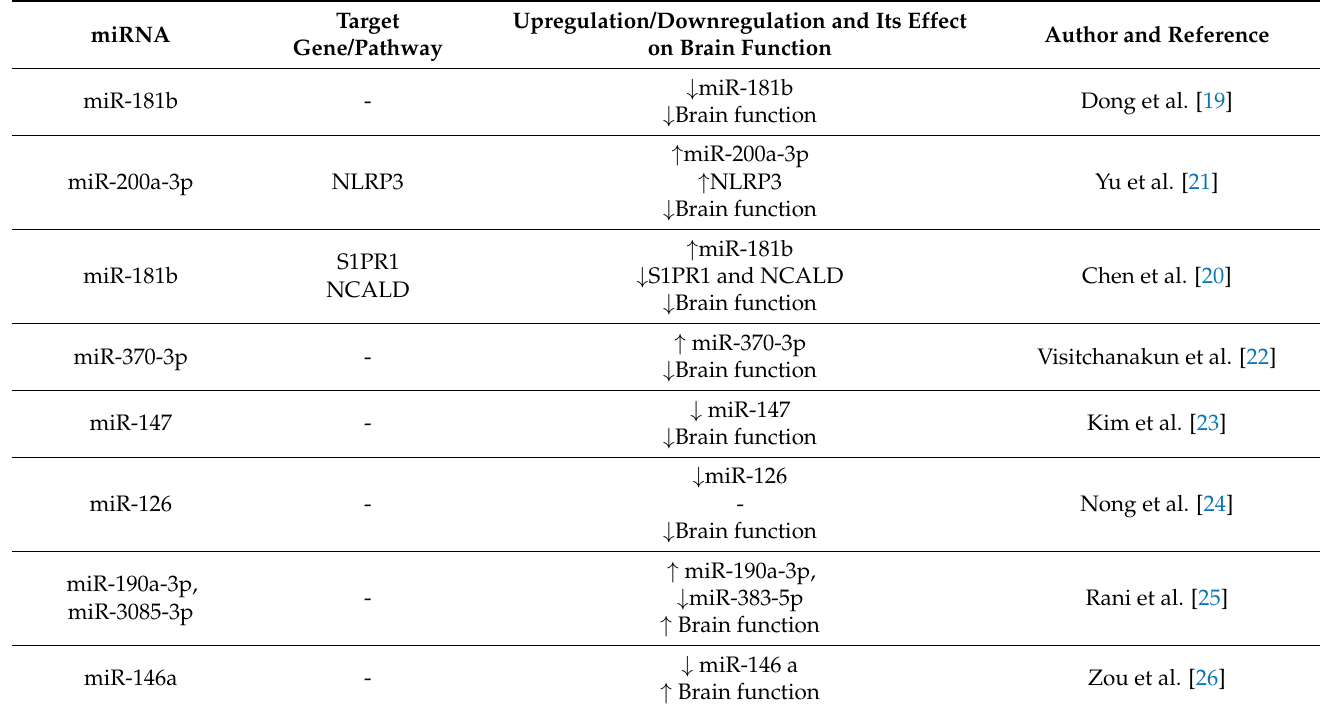
Table 7. miRNAs involved in sepsis-induced brain dysfunction and their target. ↑ indicates up regulation, ↓ indicates down regulation.